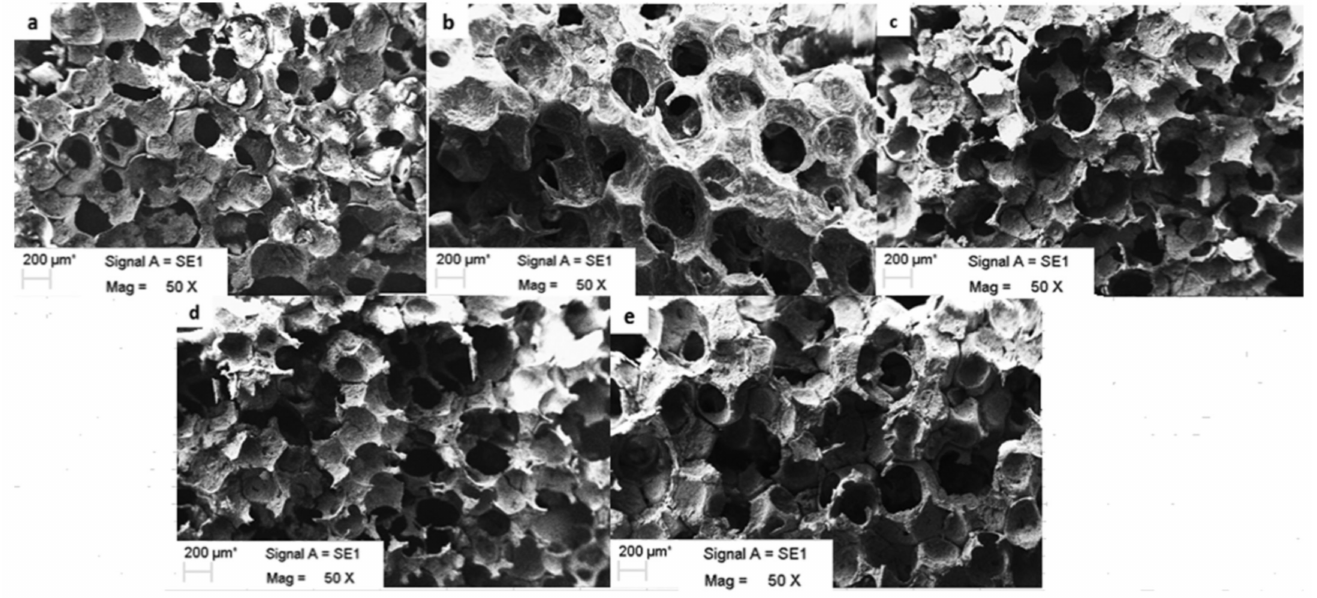
Figure 5. Scaffold with PHB-Chitosan (Cs)/MWCNTs bio-glass nanocomposite coating deposited on nano-bio-glass-titania and the PHB-Cs/1 wt% MWCNTs coated scaffold were found to improve the survival of MG-63 cells. ( a ) scaffold, uncoated ( b ) scaffold coated with PHB ( c ) scaffold coated with PHB-Cs ( d ) scaffold coated with PHB-Cs/0.5 wt% MWCNTs ( e ) scaffold coated with PHB-Cs/1 wt% MWCNTs. Reprinted from Parvizifard et al. [123] with permission from